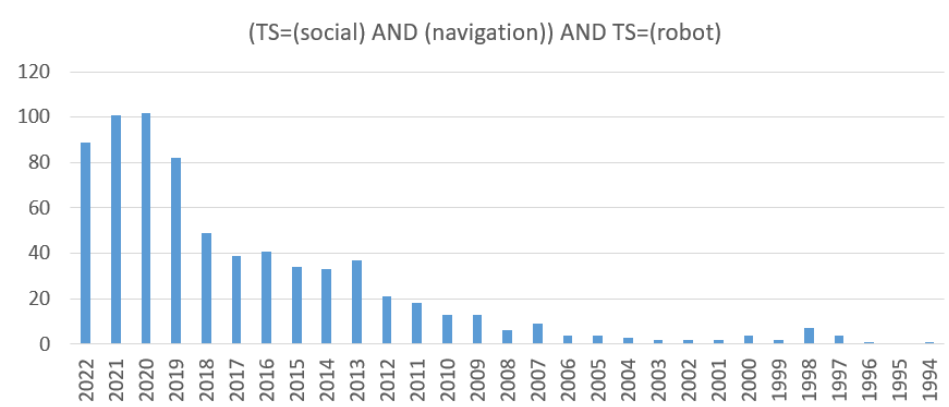
Figure 1. Web of Science Analyze filter: (TS = (social AND navigation)) AND TS = (robot).